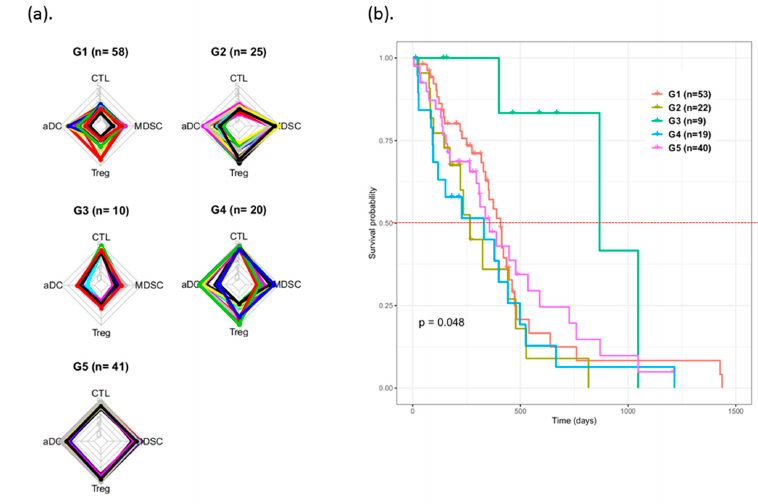
Figure 2. Prognosis of five immunophenotypes of patients with GBM. ( a ) Enrichment levels of CTL, aDC, Treg, and MDSC subsets were evaluated in terms of the immunogram score (IGS) (ranging from 0 to 5) and plotted in a radar chart. Each subset formed individual axes that have been arranged radially around a point. The IGS of each immune cell subsets are depicted by the node on the distinct axis. Each patient is represented by their own line that connects data values from each axis. ( b ) Survival curves of patients within five groups with different immune phenotypes; curves were statistically significant after a log-rank test (global p < 0.05). Each median overall survival times of curves is represented by a dotted red line.